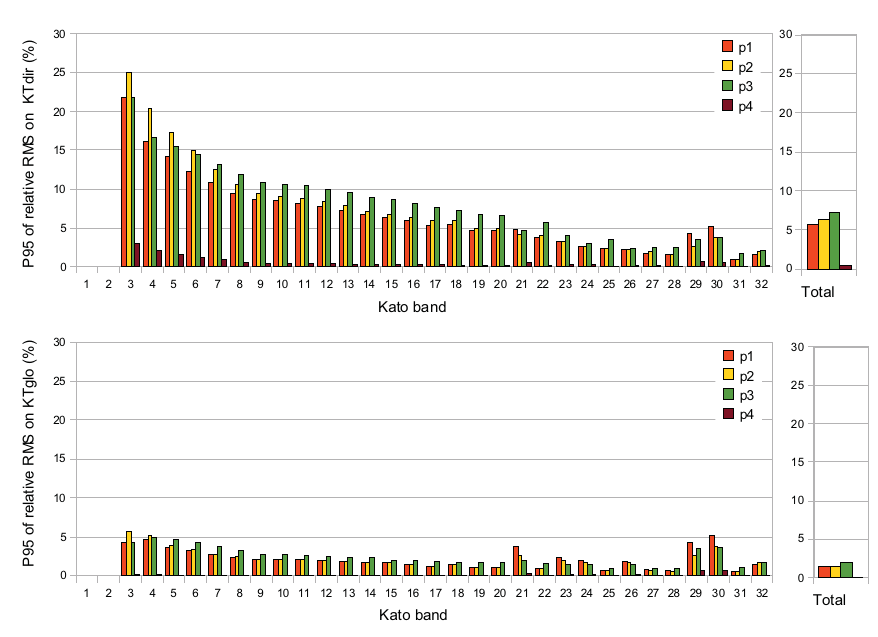
Figure 3. P95 of relative RMS for each parameterisation.